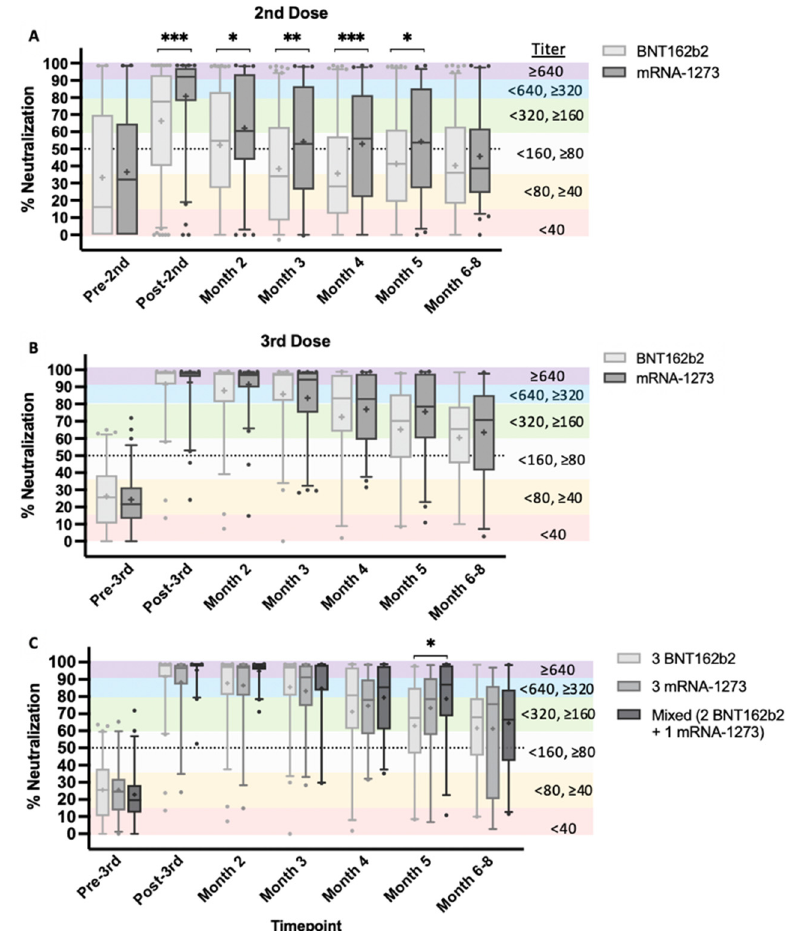
Figure 3. NAb durability of second and third mRNA vaccine doses by manufacturer. NAb test timepoints represented as percent neutralization are pre-2nd/3rd (within one week), post-2nd/3rd (2–4 weeks after second or third dose), and monthly for 6–8 months after vaccination. ( A ) Longitudinal 2nd-dose data of BNT162b2 (Pfizer) in comparison to mRNA-1273 (Moderna). ( B ) Longitudinal 3rd-dose data. ( C ) Longitudinal 3rd-dose data of individuals that received the same vaccine type for all three vaccine doses, in comparison to individuals that received two Pfizer doses and a Moderna booster dose. Data are shown as grouped box and whisker plots with error bars representing 5th–95th percentile of each population. Outliers outside of the 5th–95th percentile are shown as circular symbols above or below error bars. Graphs A and B data were analyzed using nonparametric Mann–Whitney test to evaluate mean rank between groups with a two-tailed p -value ( p < 0.05) and 95% confidence interval (CI). Graph C data were analyzed using a nonparametric Kruskal–Wallis test to evaluate mean rank between groups using multiple comparisons (two-tailed p < 0.05 and 95% CI). Titers corresponding to percent neutralization ranges are described (see Figure 2 legend). * p < 0.05, ** p <0.005, *** p <